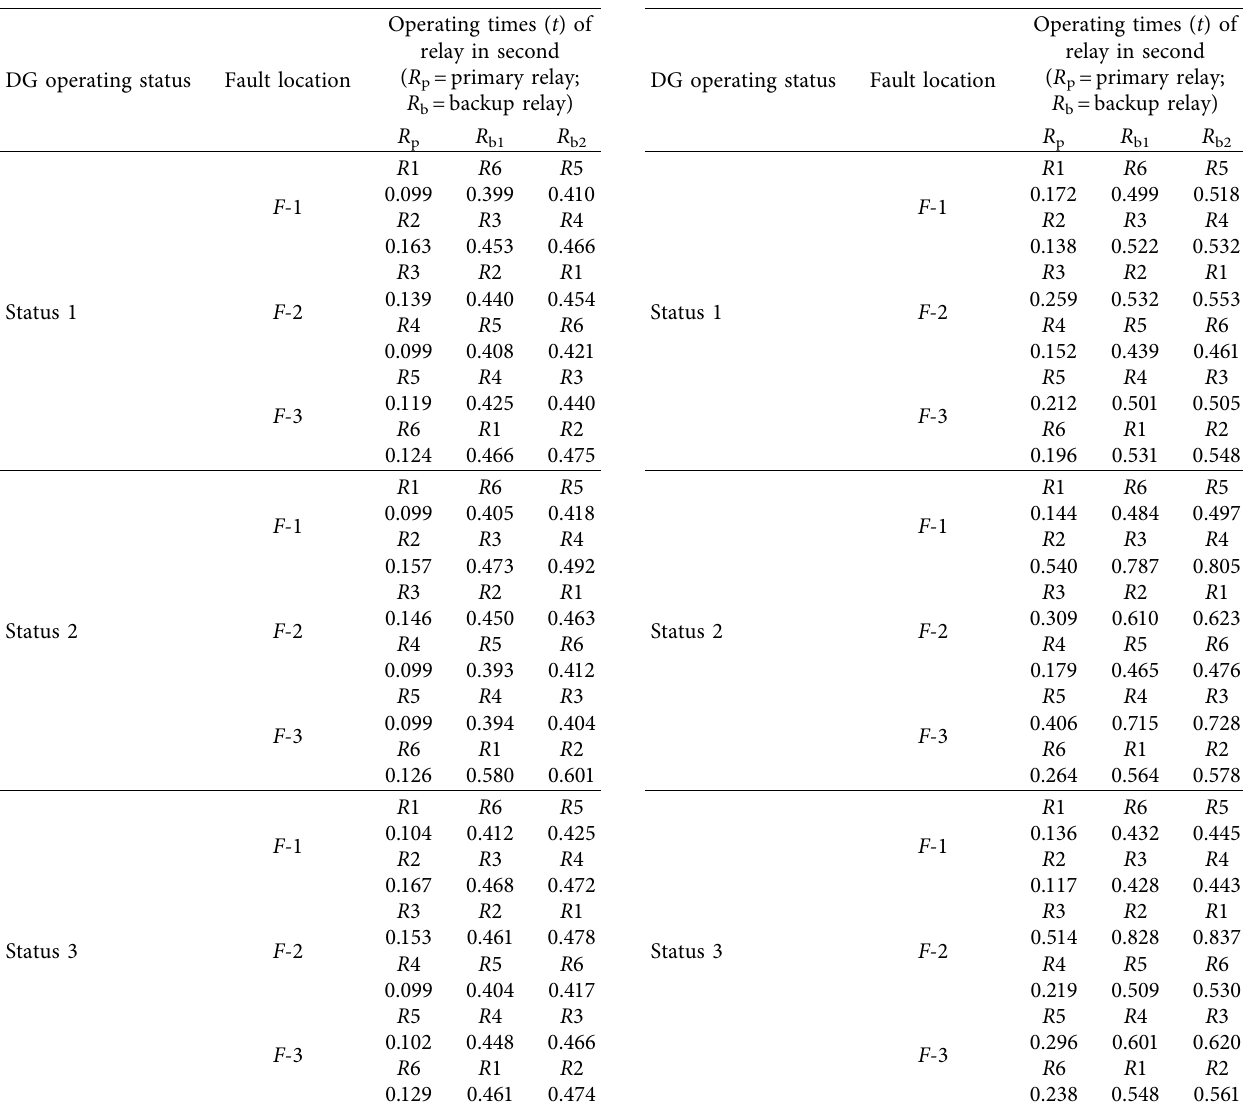
Table 10: Dual-directional primary and backup relay operating times for quaternary scheme in grid-connected microgrid.